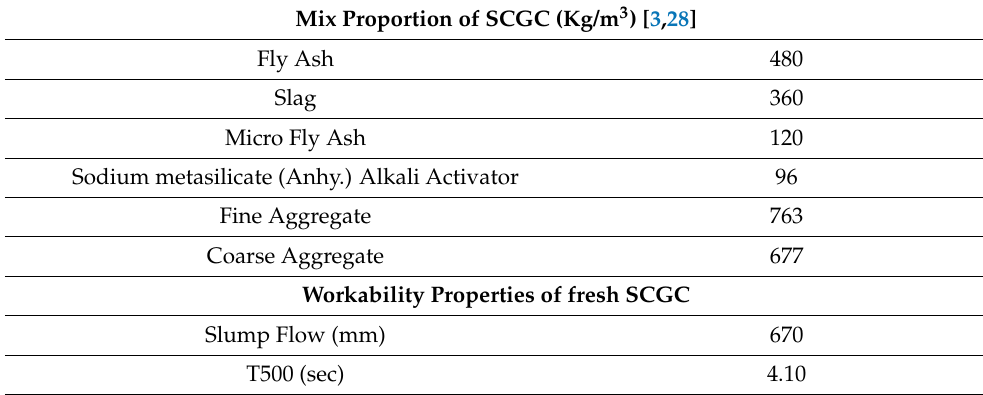
Table 3. Mix proportion and workability properties of self-compacting geopolymer concrete.